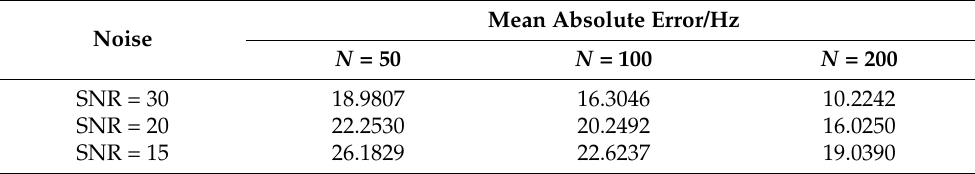
Table 2. Modal parameter identification errors under different external excitations.